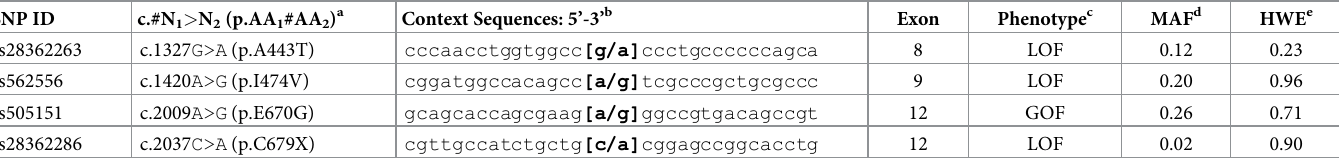
a Codon.# common nucleotide > variant nucleotide (protein.common amino acid#variant amino acid). b The polymorphic nucleotides are written in bold and bracketed. c